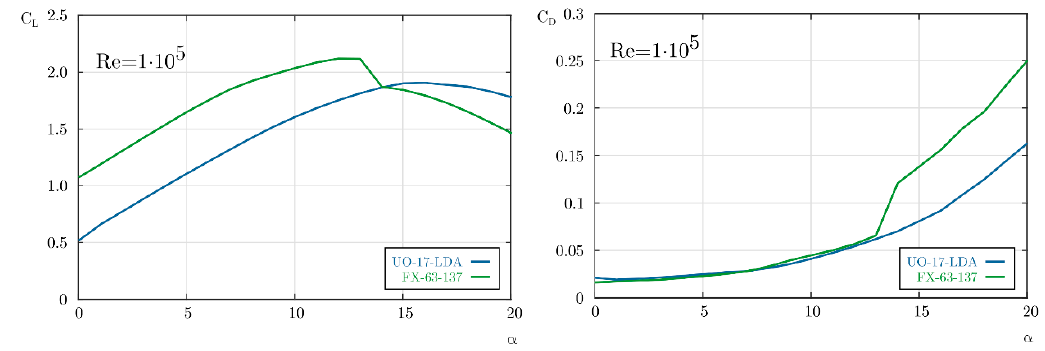
Figure 2. Enhancement of the performance of the new airfoil UO-17-LDA with respect to FX-63-137.